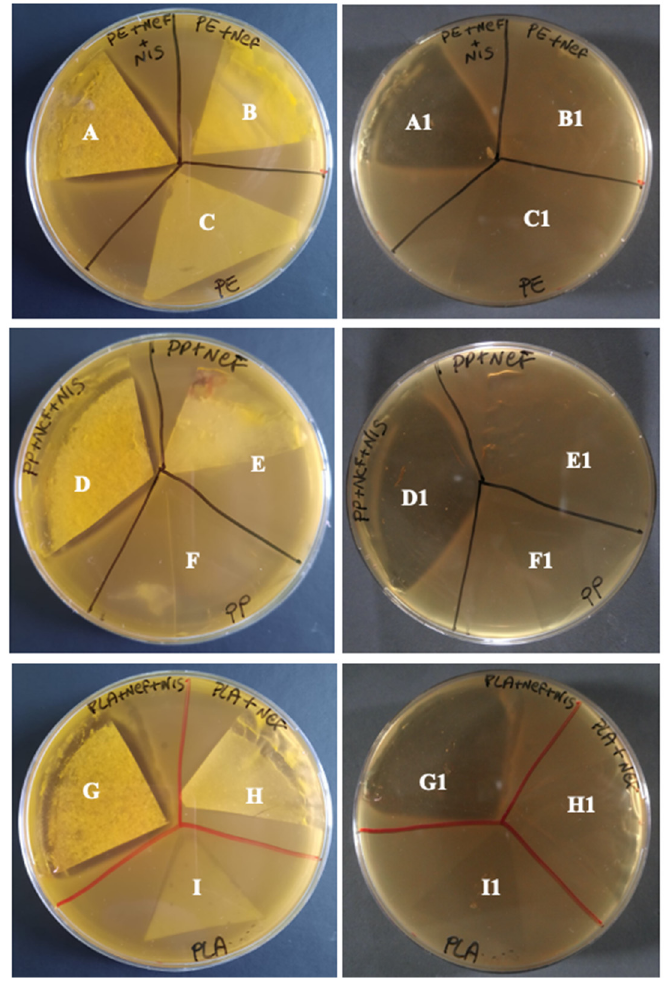
Figure 2. Coupled films and polymers alone in inhibition agar test against Brochothrix thermosphacta 7R1 before ( left side ) and after ( right side ) removing the samples from the agar. Segments A and A1, CNF-Nis+PE; segments B and B1, CNF/PE; segments C and C1, PE; segments D and D1, CNF-Nis+PP; segments E and E1, CNF/PP; segments F and F1, PP; segments G and G1, CNF-Nis+PLA; segments H and H1, CNF/PLA; segments I and I1, PLA.